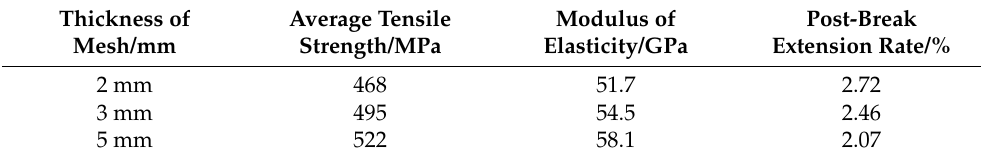
Table 3. BFRP grid material performance indicators.